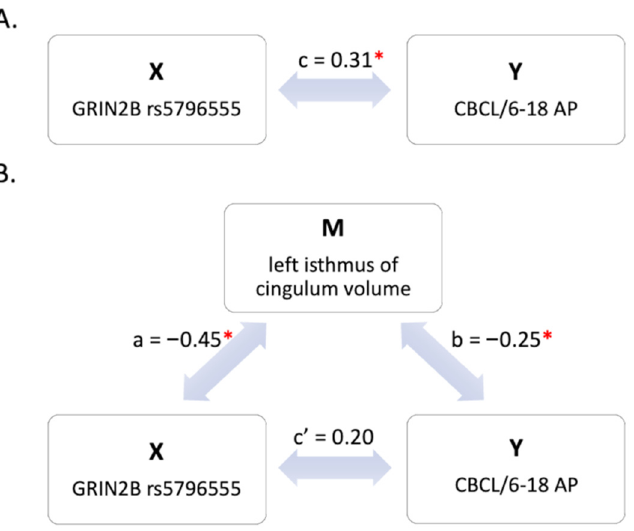
Figure 3. Mediation analysis 1 (MA1) results. ( A ) Model of direct effect of X on Y. ( B ) Mediation model, where X has both direct and indirect (through M) effects on Y. Significant pathways are highlighted with *. CBCL/6-18 AP: Child Behavior Checklist Attention Problems score.